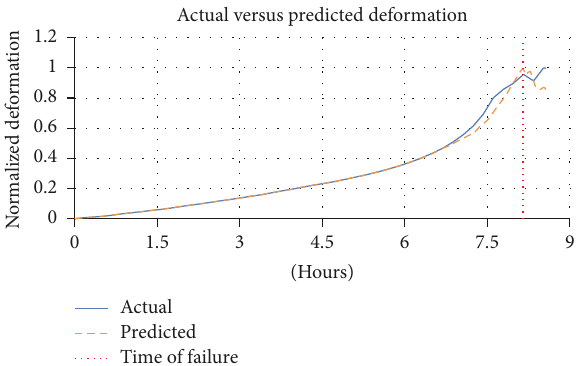
Figure 5: Actual and predicted slope failure data from mine site